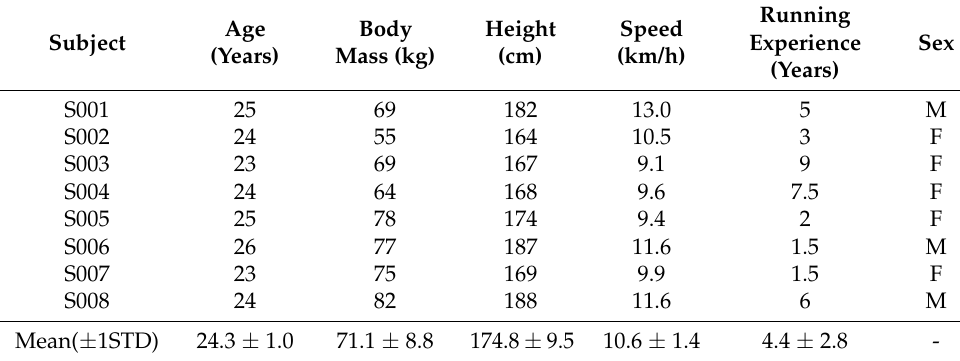
Table 1. Runners